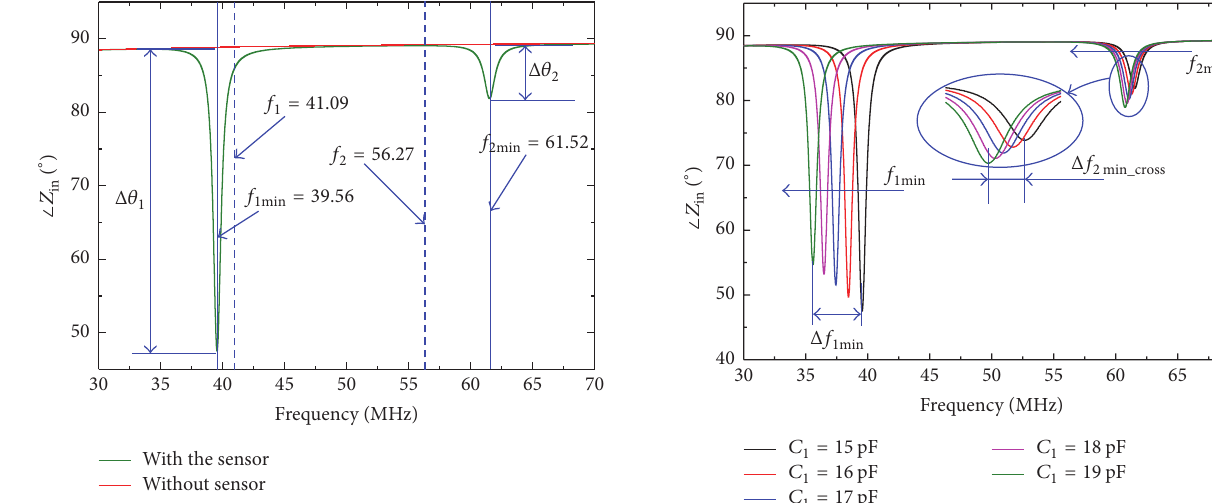
Figure 3: Phase versus frequency curve of the readout coil. Table 1: Initial design parameters of the sensor system. Symbol (unit) Value